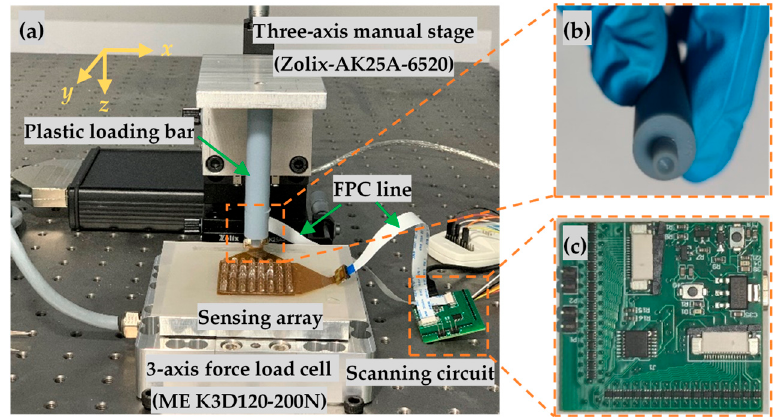
Figure 5. Experimental setup to study the sensing performance of the sensor array: ( a ) Overall view of the proposed test bench; ( b ) Plastic loading bar; ( c ) Scanning circuits for capacitance real-time measurement.